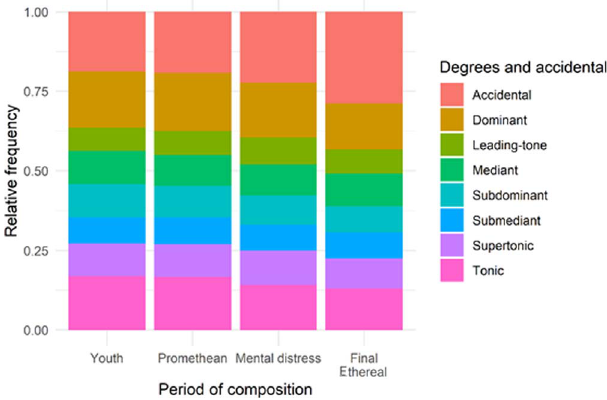
Figure 3. Relative occurrence frequencies of degrees and accidental pitches within each period of composition.